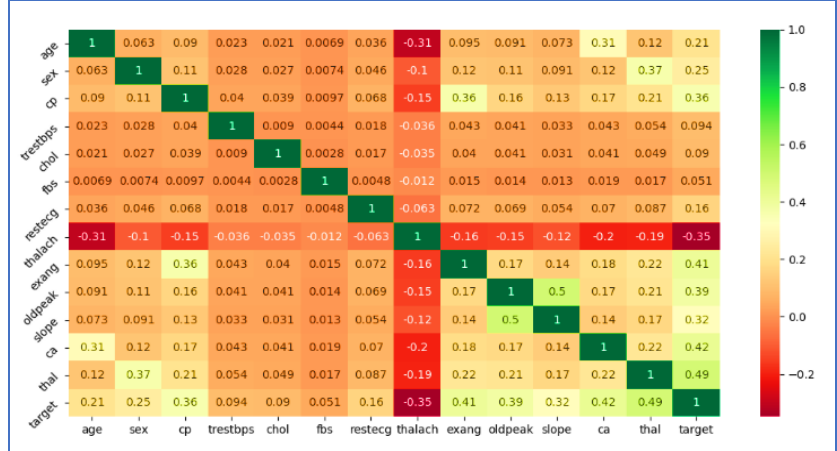
Figure 2. Correlation Matrix with a Heatmap.